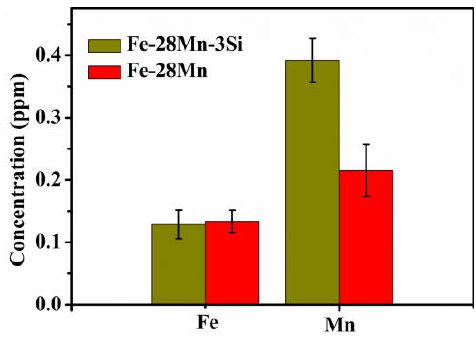
Figure 7. Concentration of Fe and Mn ions releasing from the sintered Fe–28Mn-based alloys in SBF solution after a 7-day immersion test.